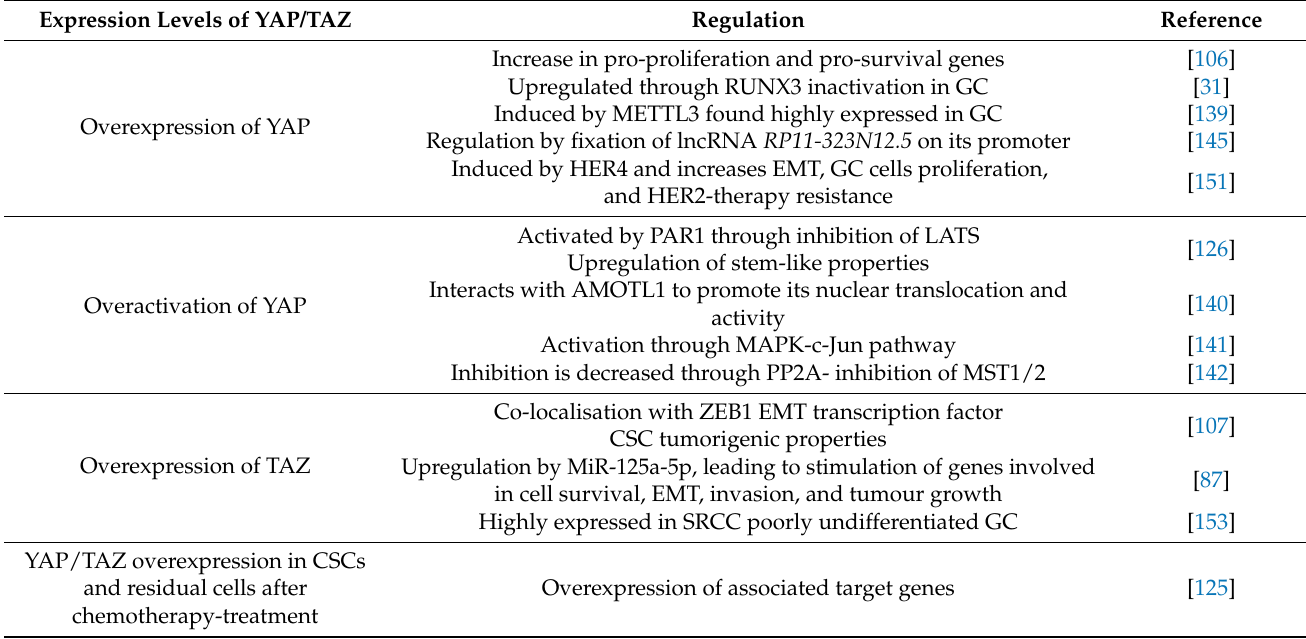
Table 1. Summary of YAP/TAZ expression, activation and regulation in GC.